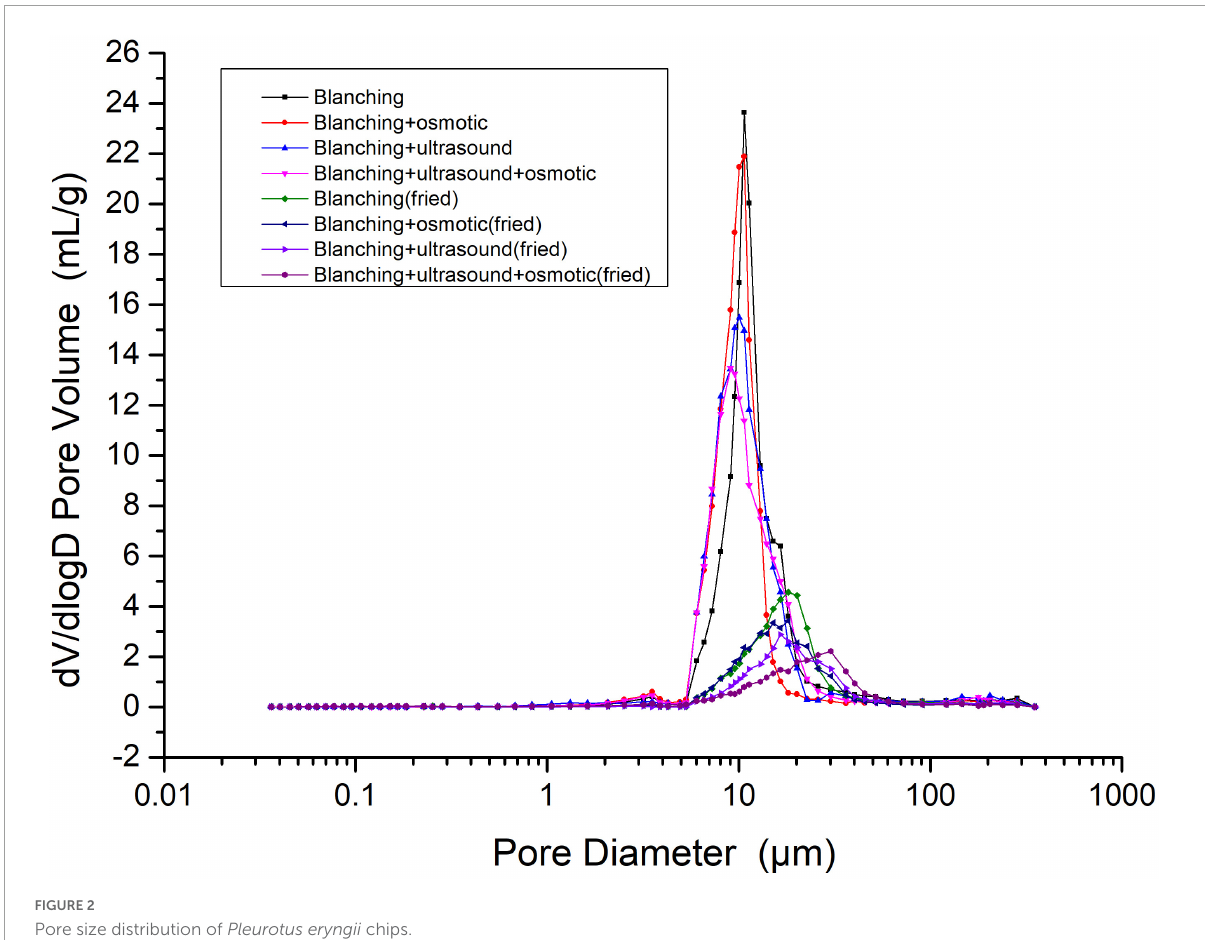
FIGURE2 Pore size distribution of Pleurotus eryngii